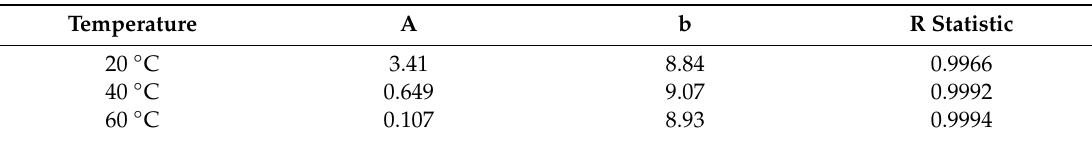
Table 2. Regression analysis of the composite viscosity of the experimental composites as a functional of temperature. (y = e bx ).